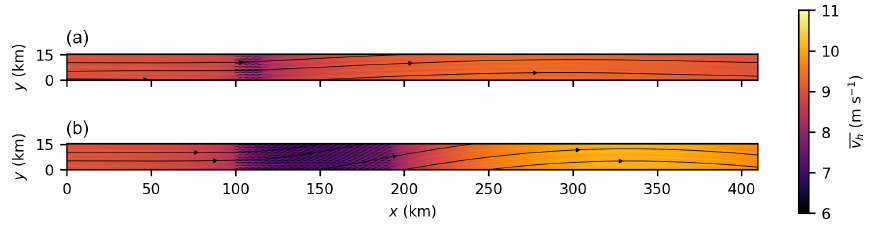
Figure 2. Mean horizontal wind speed at hub height for the small wind farm (a) and large wind farm (b) . Wind direction is indicated by streamlines.